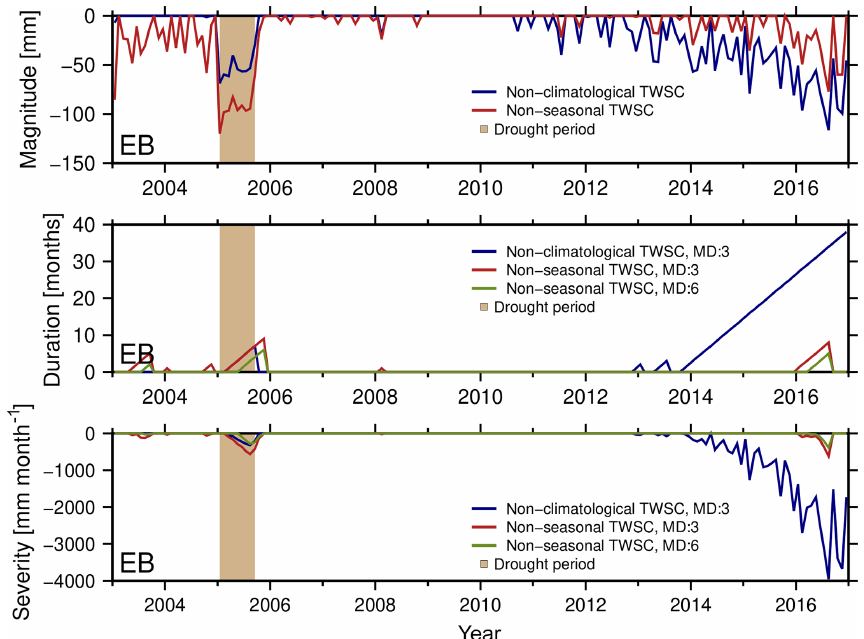
Figure 8. Drought magnitude (mm), duration (months) and severity (mmmonth − 1 ) for the cluster in eastern Brazil (EB) using TWSC with the removed climatology (dark blue) and TWSC with removed trend and seasonal signal (red). The minimum duration (MD) is set to 3 months (blue and red) or 6 months (green). Light brown shows the synthetic constructed drought